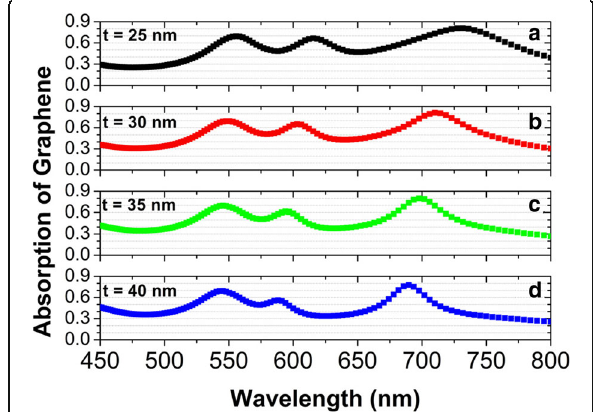
Fig. 6 ( a )-( d ) Corresponding normal-incidence absorption spectra of monolayer graphene with the thickness of the SiO 2 spacer increased